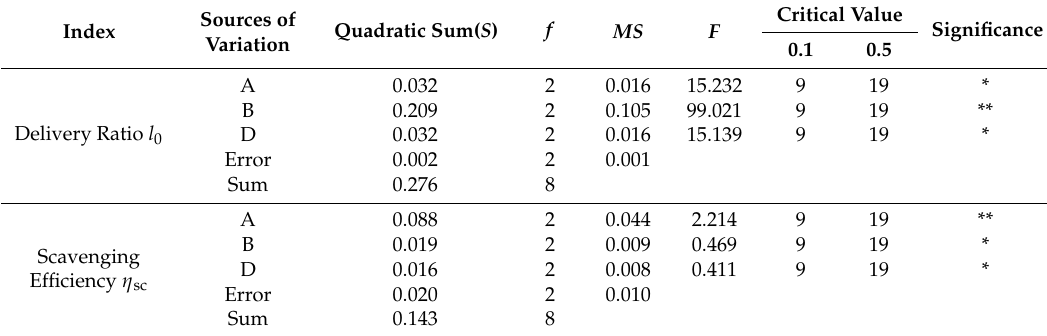
Table 5. Significance